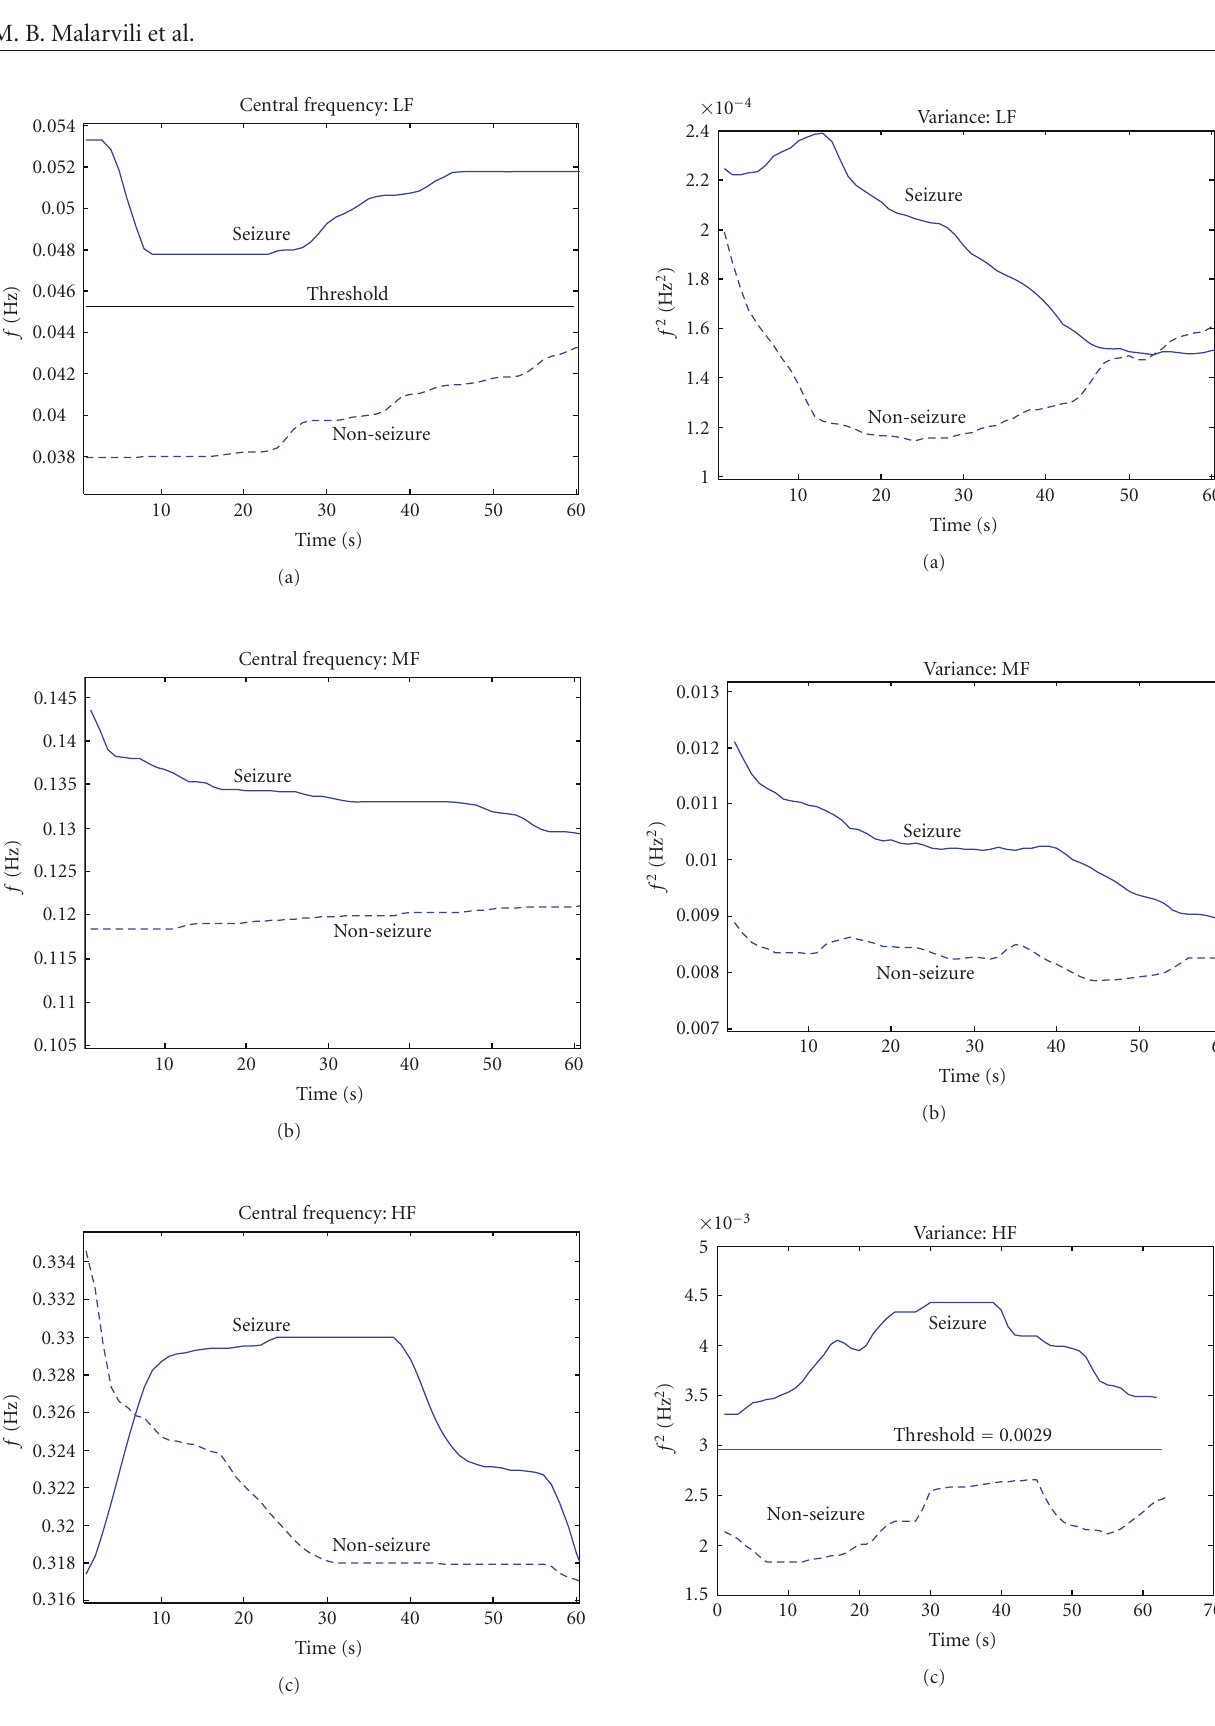
Figure 5: The central frequency of the LF, MF, and HF of the HRV. Figure 6: The variance of the LF, MF, and HF of the